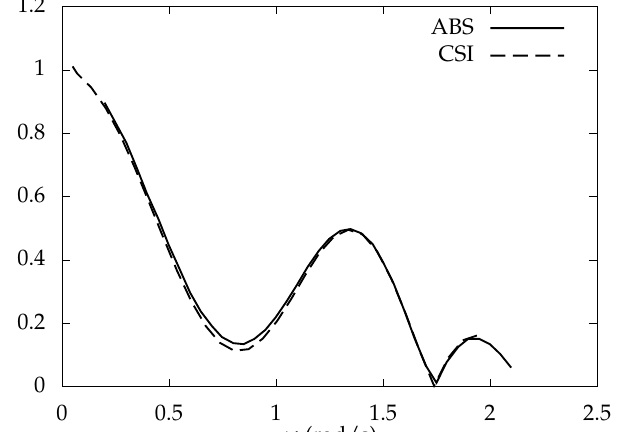
Figure 20. Effective wave slope function for C11 container ship computed using simplified “for- mal” method. Table 16. Level 2 assessment of dead ship failure mode for C11 container ship.